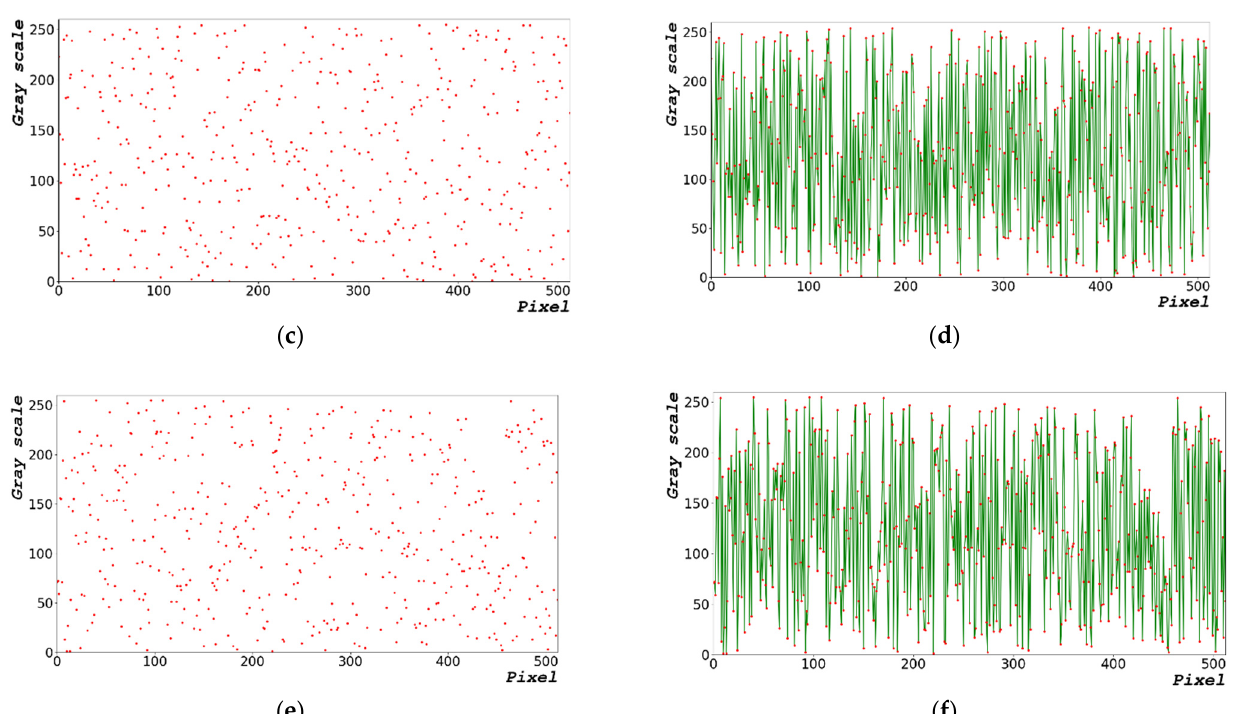
Figure 8. Random-bit generation result in radian: ( a ) 1000 × 663 random-bit generation time-series data; ( b ) trend line of Figure 8a for d X = 0.1156 rad; ( c ) 1000 × 663 random-bit generation time-series data; ( d ) trend line of Figure 8c for dx = 0.2312 rad; ( e ) 1000 × 663 random-bit generation time-series data; and ( f ) trend line of Figure 8c for dx = 1.1560 rad.